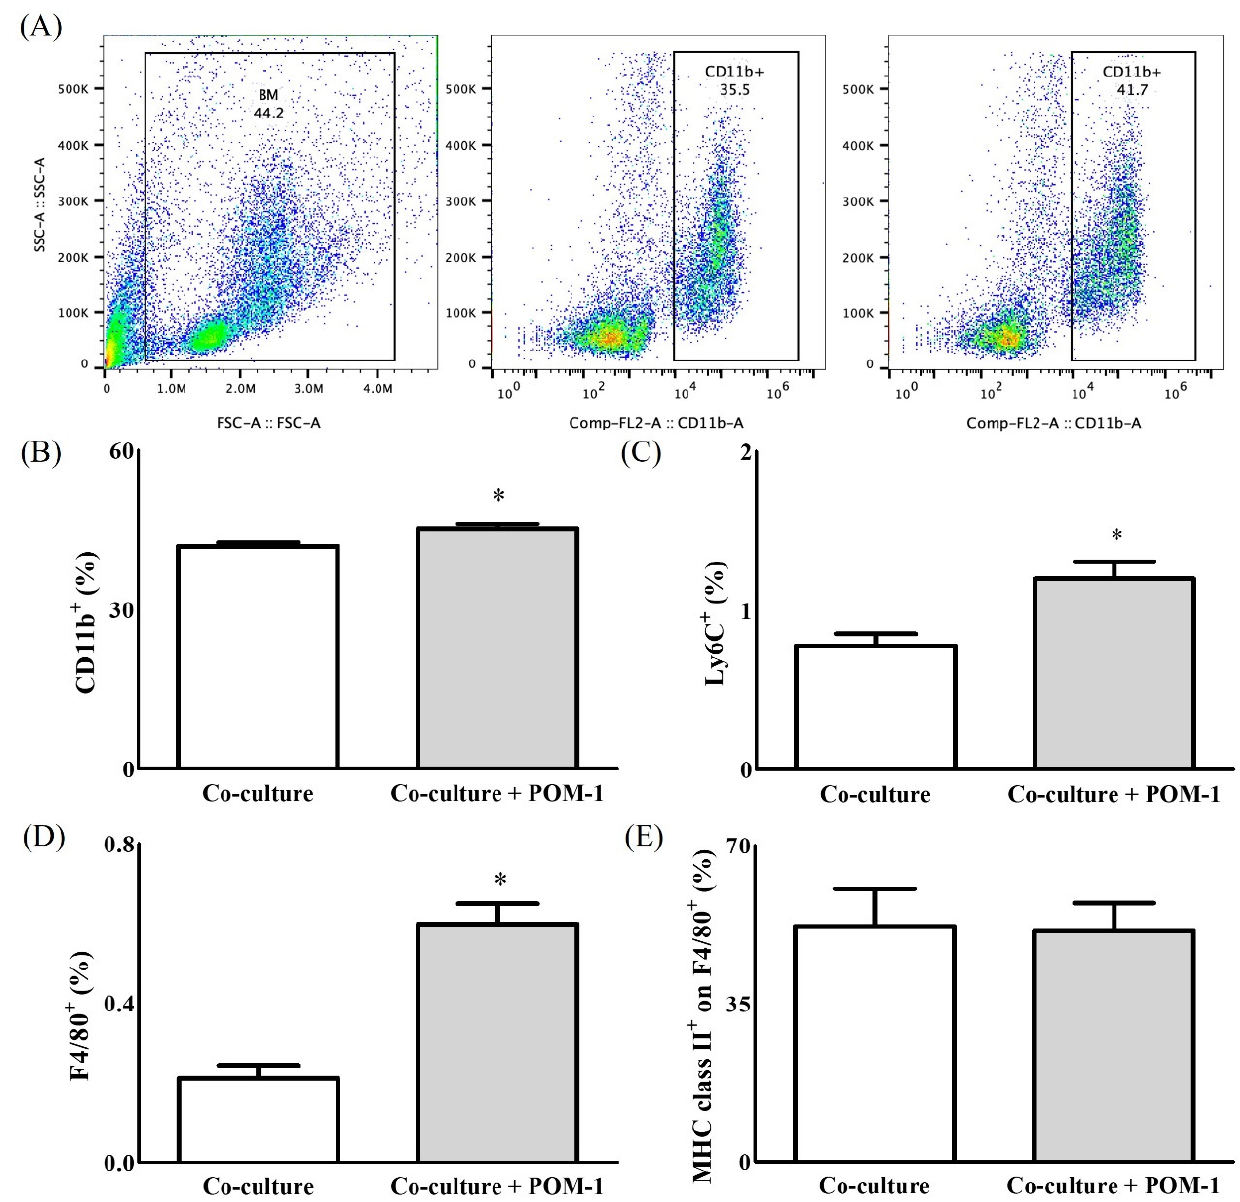
Figure 2. The expressions of immune cells in co-culture with/without polyoxotungstate (POM-1) as an inhibitor of cluster differentiation (CD)39. ( A ) Representative image of gating strategy for flow cytometry, ( B ) The expression of CD11b + for myeloid cells, ( C ) The expression of lymphocyte antigen 6 complex, locus C (Ly6C + ) for monocytes and M1-tumour phenotypes from as tumour-associated macrophages (TAMs), ( D ) The expression of F4/80 + for macrophages and ( E ) The expression of major histocompatibility complex (MHC) class II + for M1-tumour phenotypes from TAMs. *: p < 0.05.